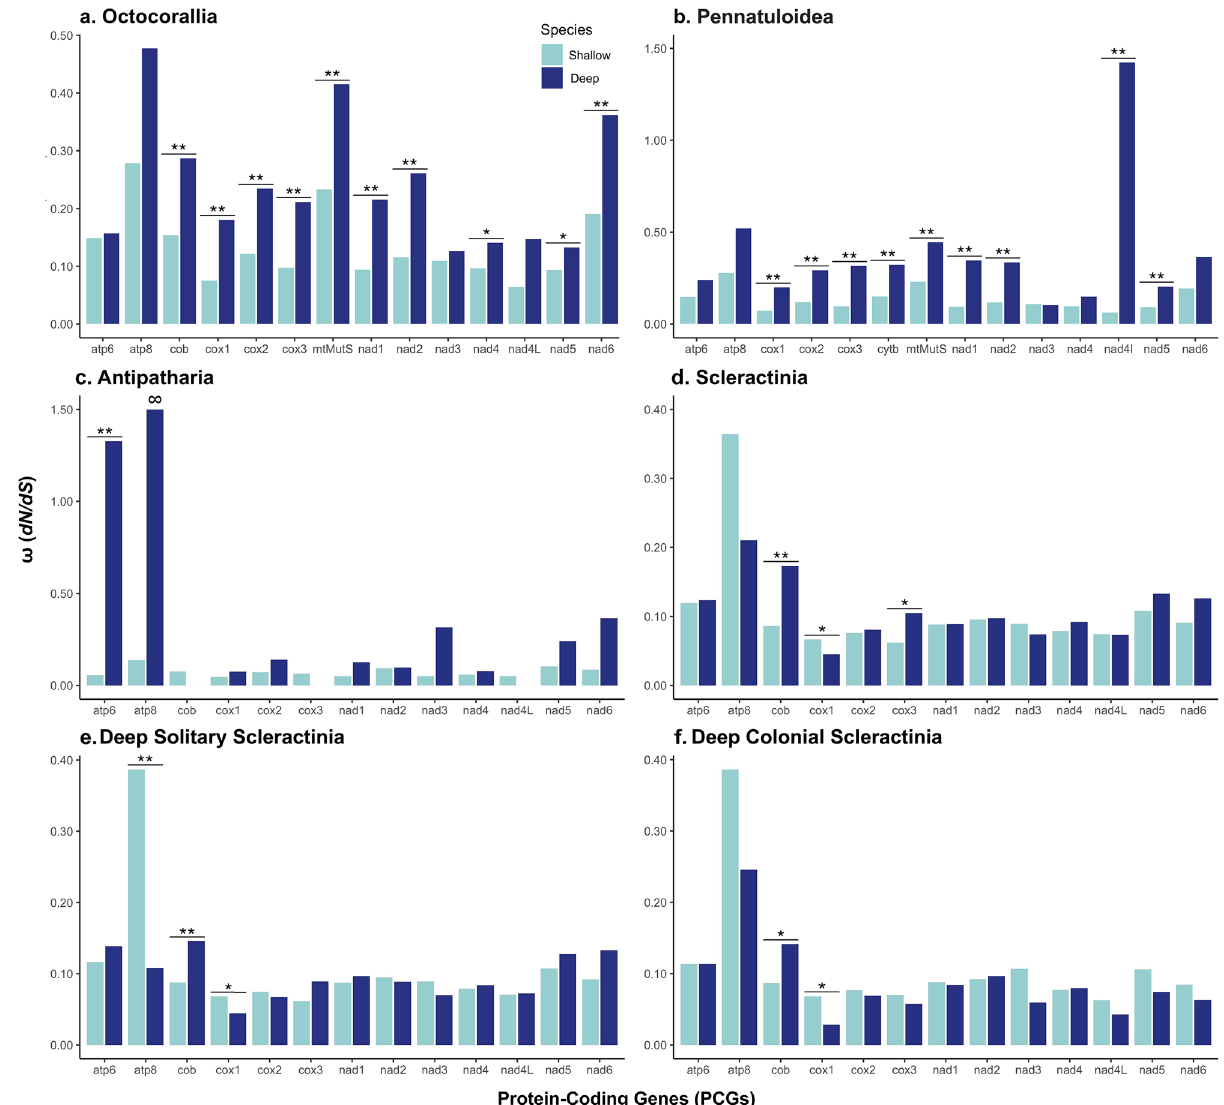
Figure 1. Average ω of each mt PCG estimated by branch-model analysis (M0 vs. M2) of deep- and shallow- water species of corals. Foreground set as deep-sea species of ( a ) Octocorallia, ( b ) Pennatuloidea, ( c ) Antipatharia, ( d ) Scleractinia, ( e ) Deep Solitary Scleractinia, ( f ) Deep Colonial Scleractinia *p < 0.05, **p < Scleractinia. All scleractinian mt PCGs were under purifying selection (ω < 1) in the branch-model analysis.